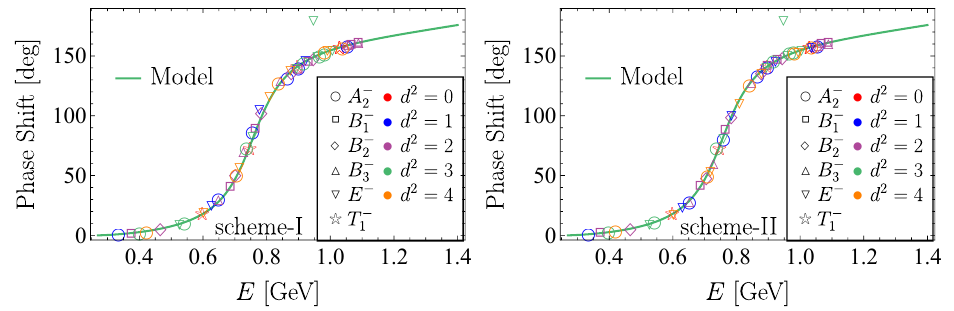
Figure 12 . P-wave ππ phase shifts of the phenomenological model defined in eq. (6.8) (solid lines) in comparison with the phase shifts extracted from the FV energies using the single-channel Lüscher formula (various symbols). Left and right panels correspond to two different schemes for discretizing the momenta in the moving frames as explained in section